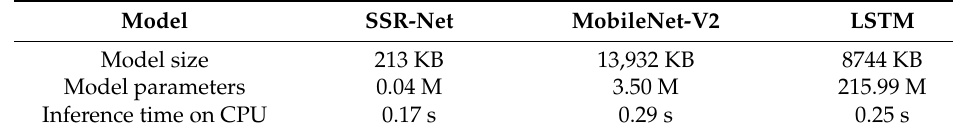
Table 1. Comparison of different lightweight deep learning models.